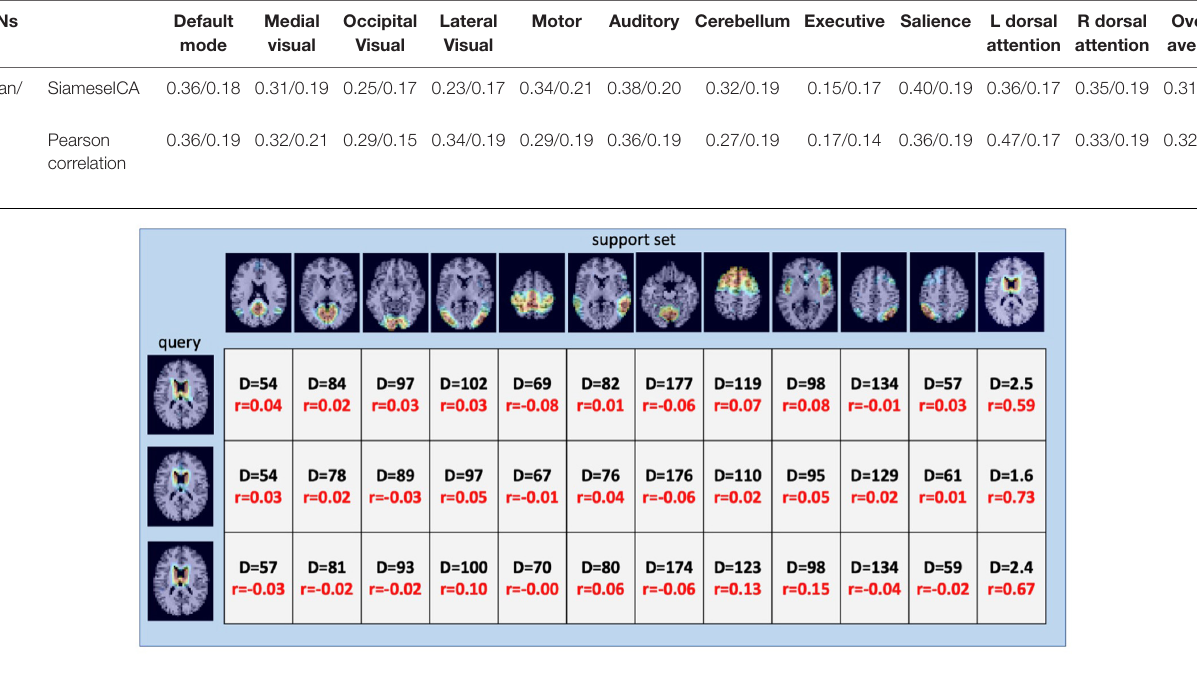
FIGURE 12 | One-Shot classification of the caudate RSN using 12-way 1-shot classification. 12-way includes the 11 RSN classes of Figure 8 (DMN; MVN; OVN; LVN; AN; EN; MN, CN, SN; LDAN; and RDAN) and the additional caudate network (last column). The values represent the distance metric (color black) and Pearson correlation (color red) calculated between the support set and the queries. Distances resulting from querying the network using three examples of ICA components matching the Caudate Network (left column) are small and provide the correct classification, as does Pearson Correlation.